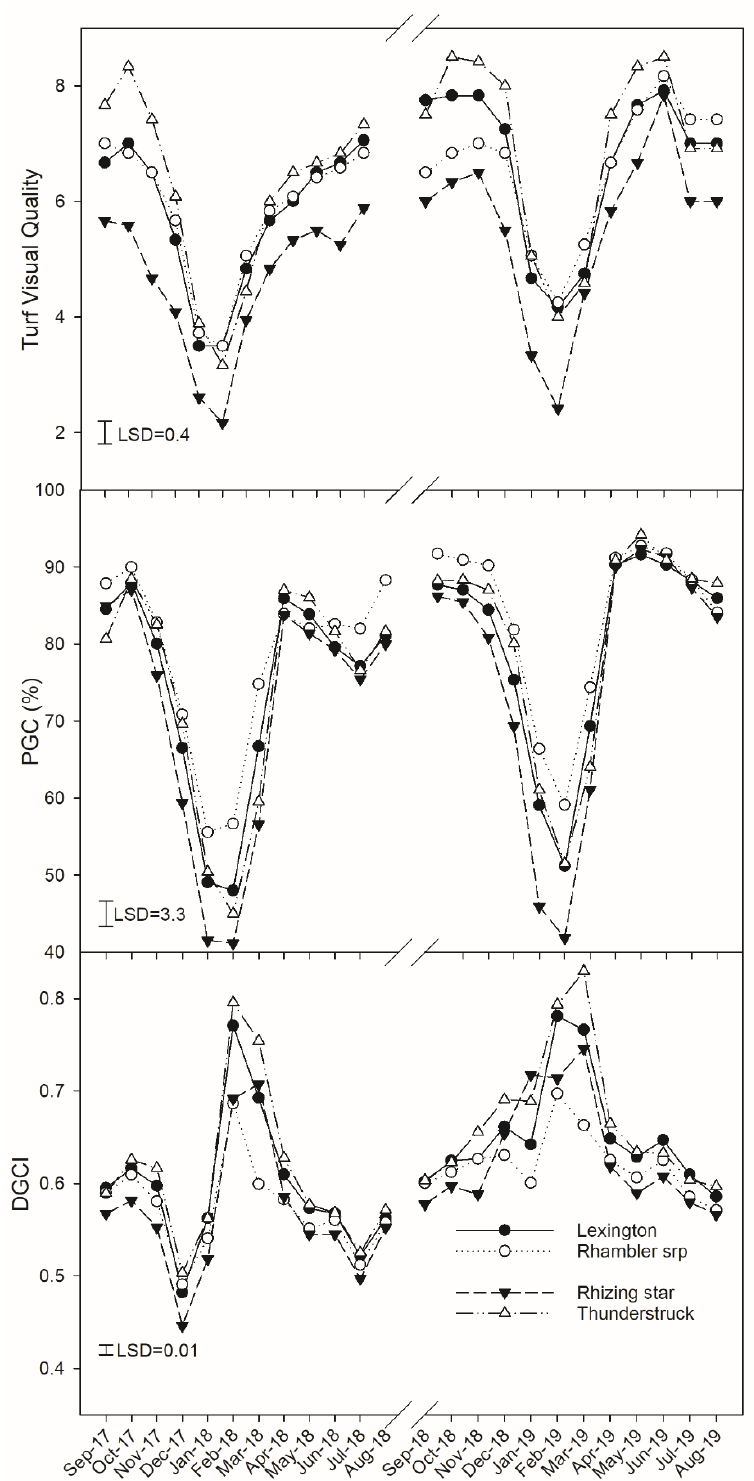
Figure 1. Turfgrass quality, percent green cover (PGC), and dark green color index (DGCI) of four tall fescue cultivars (‘Lexington’, ‘Rhambler SRP’, ‘Rhizing star’, and ‘Thunderstruck’) as affected by year and month. Data are averaged over 2 N rates and 3 replicates, and represent an average of 6 data points. Turfgrass quality was visually assessed (1−9 scale), PGC and DGCI were determined through digital image analysis.